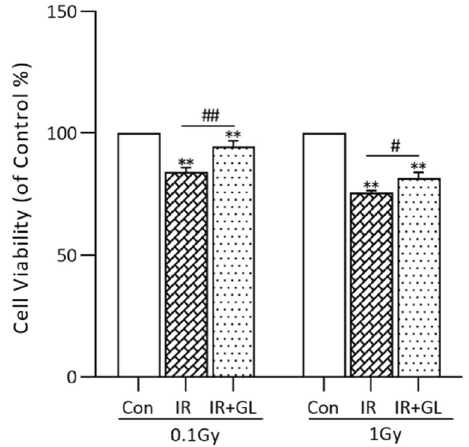
Figure 4. Cell viability of the isolated splenocytes according to radiation dose. Cell viabilities were significantly lower in the IR only groups (both in 0.1 Gy and 1 Gy) compared to the control group, whereas they were significantly higher in the IR + GL groups compared to the IR only groups. Results are expressed as means ± SEM from duplicate experiments for each group. The asterisk (*) indicates significant differences between the control and IR groups (both of the untreated and GL treated groups). The hash sign (#) indicates significant differences between the IR groups and IR + GL groups. ** p < 0.01, ## p < 0.01, # p < 0.05. IR irradiation, GL